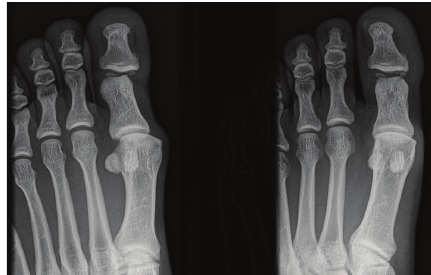
Figure 1: This is the dorsoposterior and oblique radiographs obtained at the emergency department. It reveals an oblique IP joint space of the left great toe, raising suspicion of a dislocation. As a true lateral radiograph was not obtained, the diagnosis was missed.